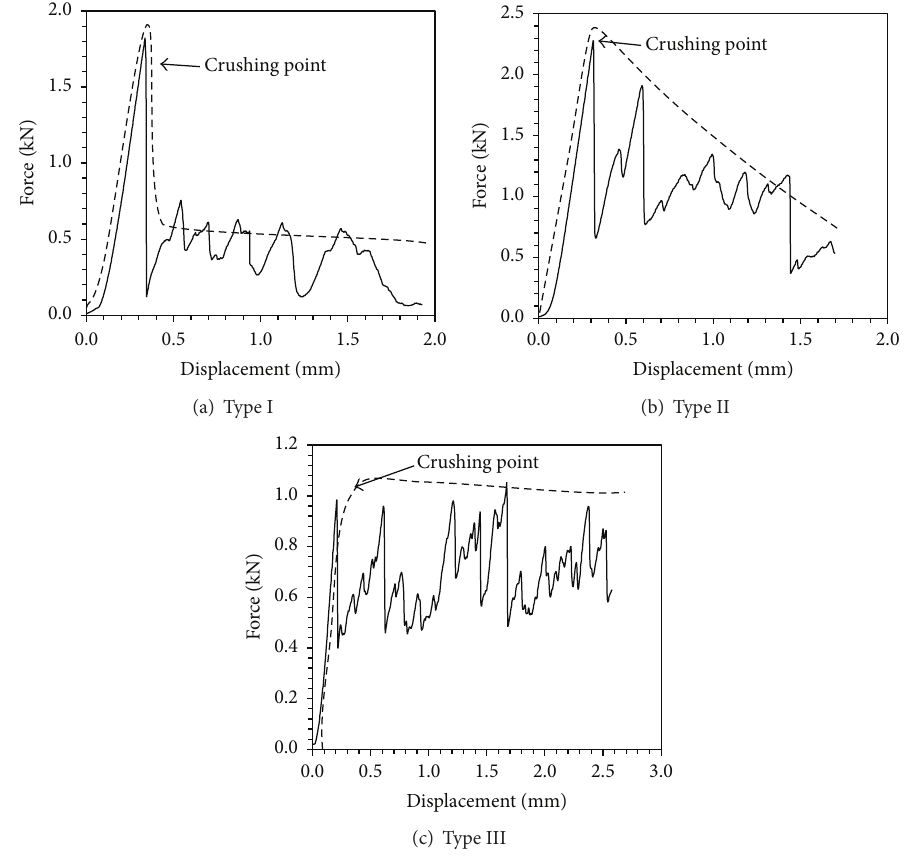
Figure 3: Typical force-displacement relationship.